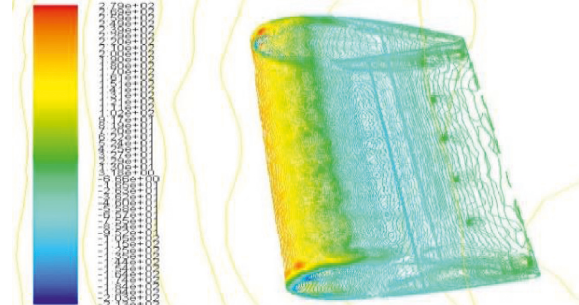
Figure 14: Total pressure at 0 ° AOA for the 3rd module.